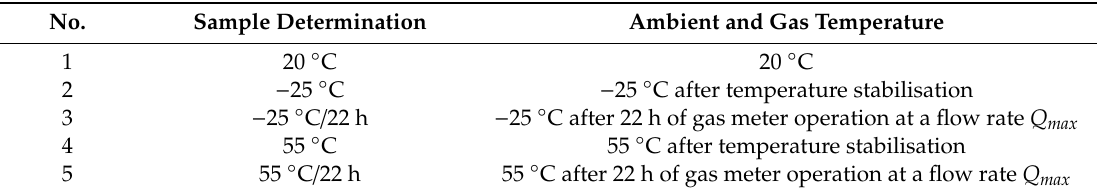
Table 2. Variants of tests at ambient and gas